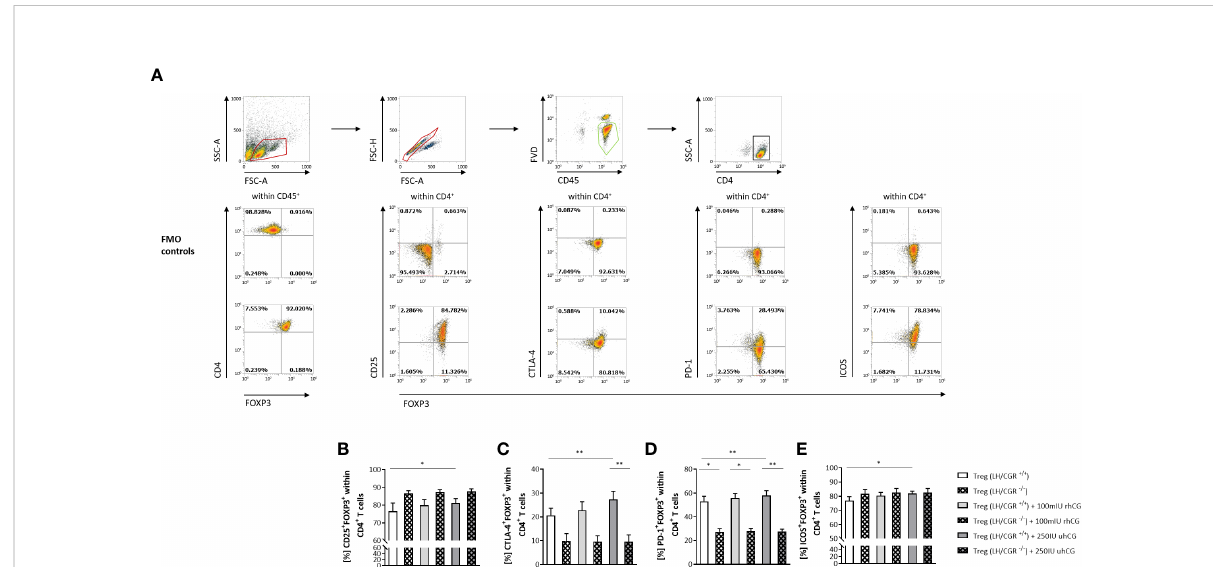
FIGURE 1 rhCG and uhCG stimulated formation of Treg cells through the LH/CGR in vitro. CD4 + CD25 + T cells were isolated by magnetic-activated cell sorting (MACS) and cultured for 24 h in the presence of 250 IU/ml uhCG or 100 mIU/ml rhCG, or absence of hCG as controls. Following culture, the frequencies of CD4 + FOXP3 + Treg cells expressing CD25, CTLA-4, PD-1 or ICOS were determined by fl ow cytometry. (A) Representative dot plots showing the gating strategy and fl ow-cytometric results of control FMO staining and full staining for all marker molecules except for the lineage markers CD4 and CD45. (B – E) Graphs showing the percentages of CD25 + FOXP3 + , CTLA-4 + FOXP3 + , PD- 1 + FOXP3 + and ICOS + FOXP3 + cells within all CD45 + CD4 + T cells. CD4 + CD25 + T cells from WT (LH/CGR +/+ ; n = 6) or LH/CGR-de fi cient (LH/ CGR -/- ; n = 4) female mice were included in the assays. All assays were run in duplicate. Data are presented as the mean plus standard error of the mean (S.E.M.). Statistical analysis among LH/CGR +/+ or LH/CGR -/- groups was performed using the Friedman test followed by Dunn ’ s multiple-comparison test. For comparisons between LH/CGR +/+ and LH/CGR -/- groups, the Kruskal – Wallis test followed by Dunn ’ s multiple- comparison test was used. * indicates p < 0.05; ** indicates p < 0.01. Following, means plus S.E.M. are provided for signi fi cant differences between LH/CGR +/+ plus uhCG vs LH/CGR +/+ w/o hCG for CD25: 81.10 ± 2.606 vs 76.56 ± 4.575; CTLA-4: 27.37 ± 3.390 vs 20.60 ± 3.044; PD-1: 58.00 ± 4.020 vs 52.85 ± 4.442; ICOS: 81.95 ± 1.665 vs 76.75 ± 3.023 and LH/CGR +/+ plus uhCG vs LH/CGR -/- plus uhCG for CTLA-4: 27.37 ± 3.390 vs 9.554 ± 2.877; LH/CGR +/+ vs LH/CGR -/- for PD-1 52.85 ± 4.442 vs 27.39 ± 2.699 (w/o hCG); 55.94 ± 3.735 vs 27.99 ± 2.287 (rhCG); 58.00 ± 4.020 vs 27.80 ± 1.897 (uhCG). LH/CGR, luteinizing hormone/chorionic gonadotropin receptor; rhCG, recombinant hCG; uhCG, urine-derived